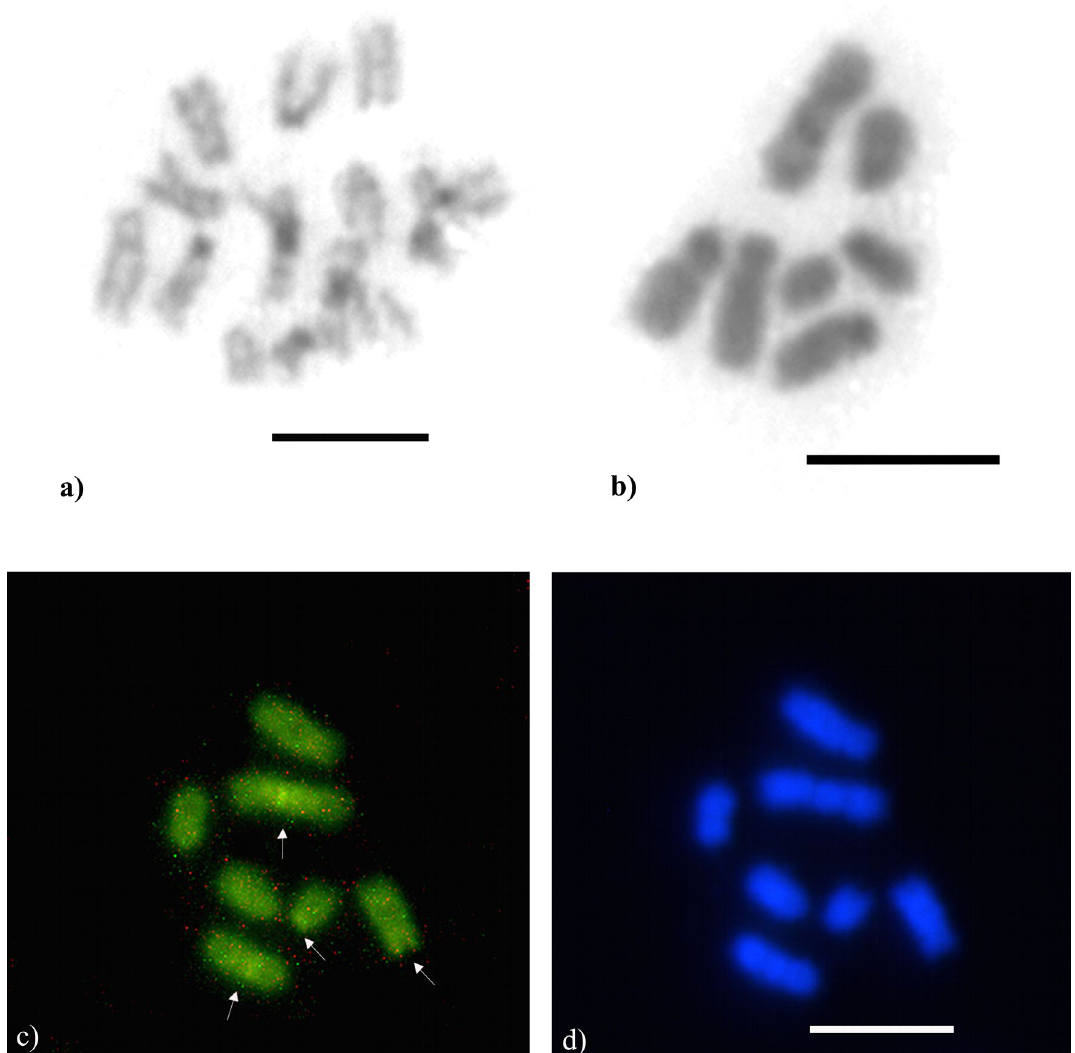
Figure 8. Metaphase chromosomes of the fungus-growing ant Mycocepurus smithii from a sexual population marked with the C-banding technique and stained with fluorochromes. ( a ) C-banding technique in female (2n = 14); ( b ) male (n = 7). Black regions indicate the presence of heterochromatin. ( c ) Metaphase stained sequentially with the fluorochromes CMA 3 ; ( d ) DAPI, for detection of regions rich in GC and AT base pairs, respectively. White arrows indicate the presence of GC-rich blocks. Scale bar represents 5